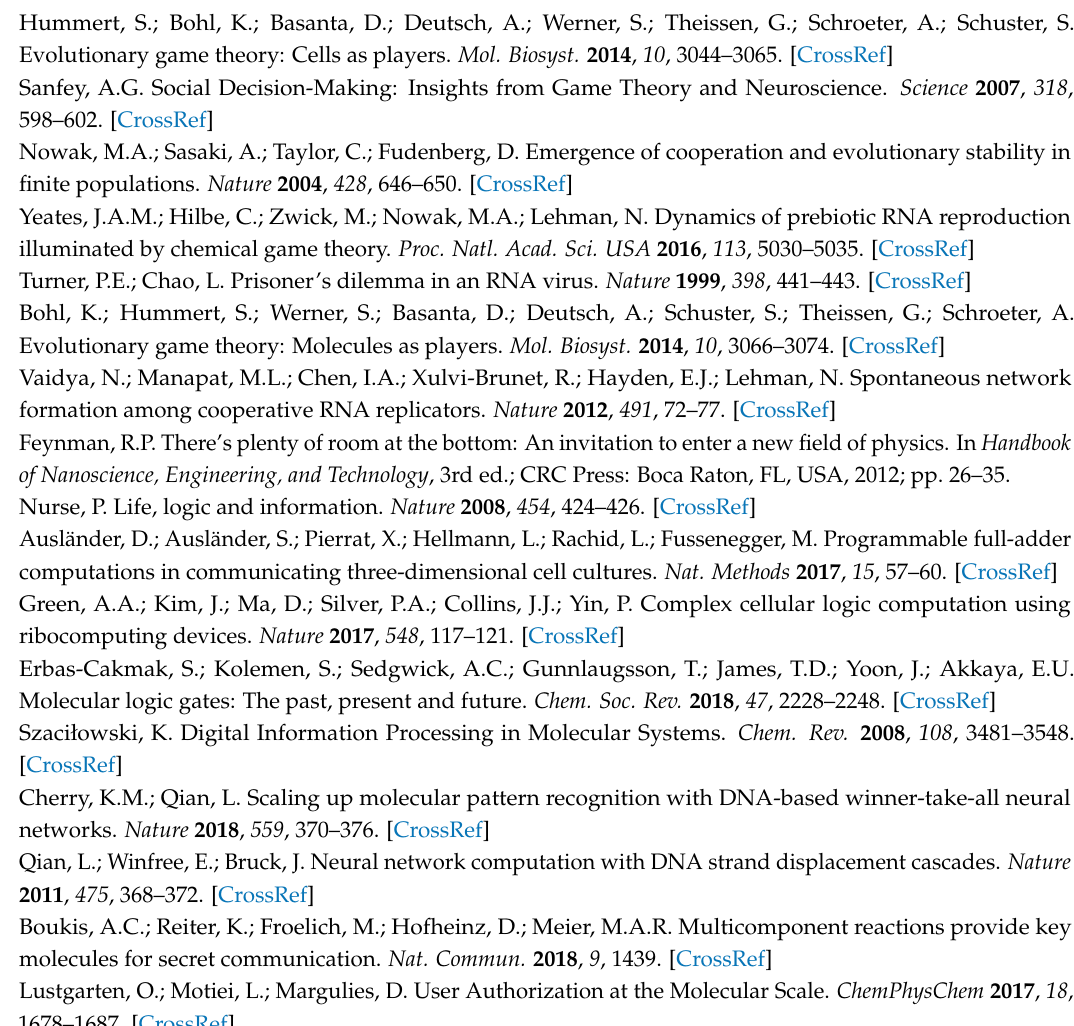
s1, Figure S1: Comparison of fluorescence quenching ability of CoOOH to different fluorescence dyes. Figure S2: Characterization of CoOOH nanosheets. Figure S3: Comparison of ζ -potential for CoOOH, T33–CoOOH, and T33–CoOOH–Hg 2+ mixtures. Figure S4: Comparison of fluorescence changes in free fluorescein, T33, and T33–CoOOH complexes at different concentrations of Hg 2+ . Figure S5: Optimization of the concentration of CoOOH nanosheets. Figure S6: Optimization of reaction time. Figure S7: Competition experiment and the interference of anions. Figure S8: T33–CoOOH complexes for detection of A33 DNA. Table S1: Comparison of the detection slimit and linear ranges of other reported Hg 2+